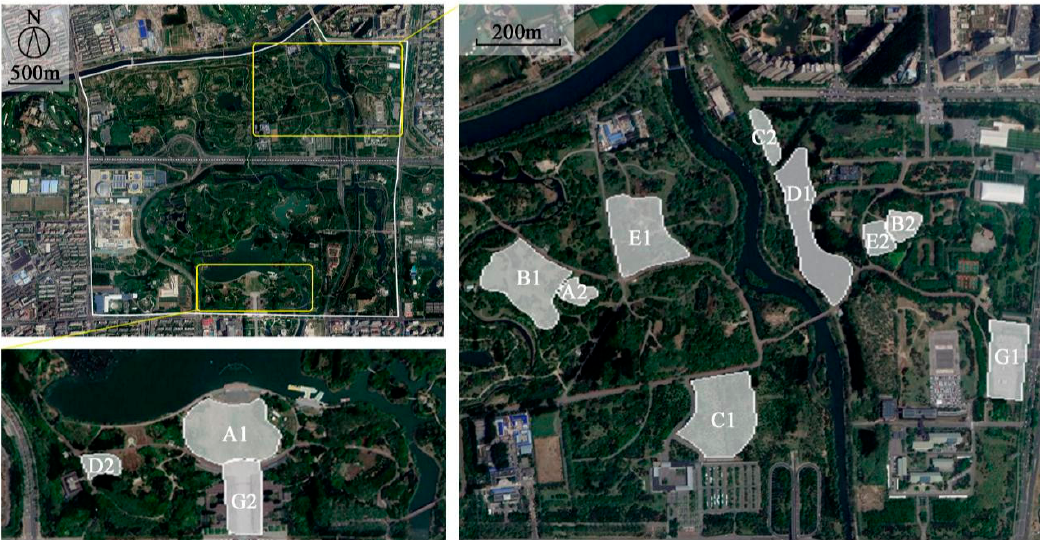
Figure 1. Study area. “A–E” represent forests of five different vegetation structure types. “G” represents gray space. “1” represents forests of 0.4–0.5 ha. “2” represents forests of 2.7–3.0 ha. Table 1. Classification with three dimensions of urban forest in Beijing. First Dimension Second Dimension Third